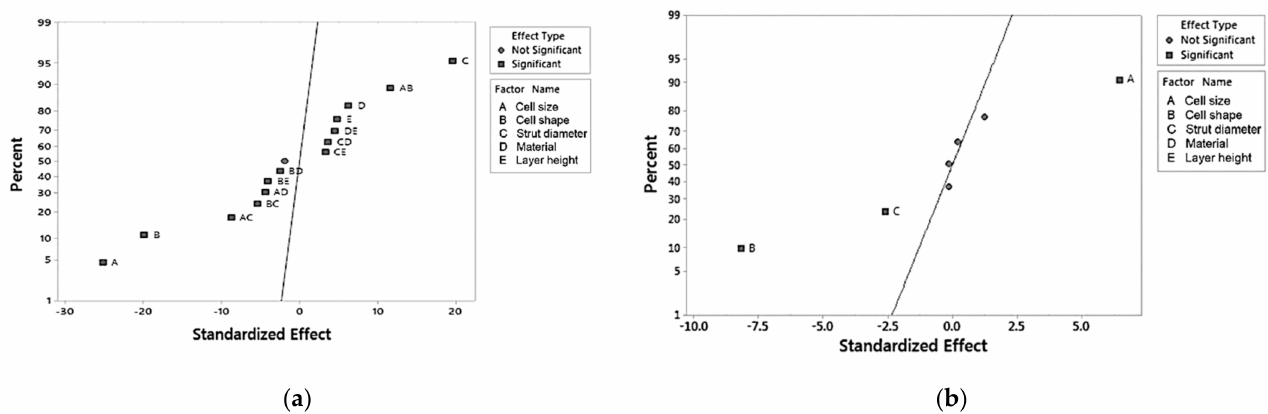
Figure 5. Normal plot of standardized effects for ( a ) plateau stress, σ pl ; ( b ) elastic modulus, E. The 2.12 line indicates a significance of the 95% confidence interval ( α =